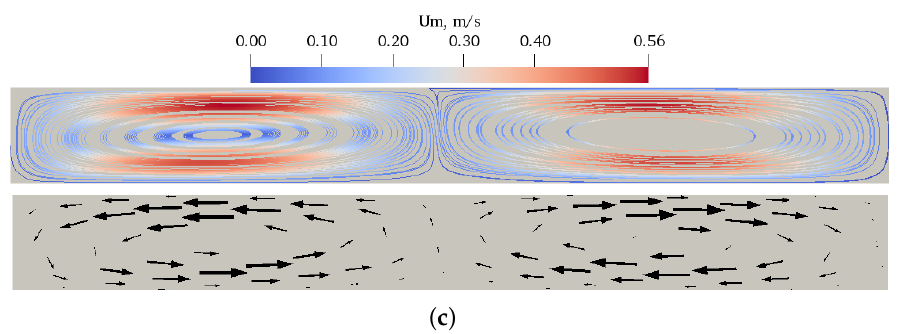
Figure 6. Streamlines depicting streaming velocity U m for cases 2A–2C ( f = 40 kHz). ( a ) Case 2A